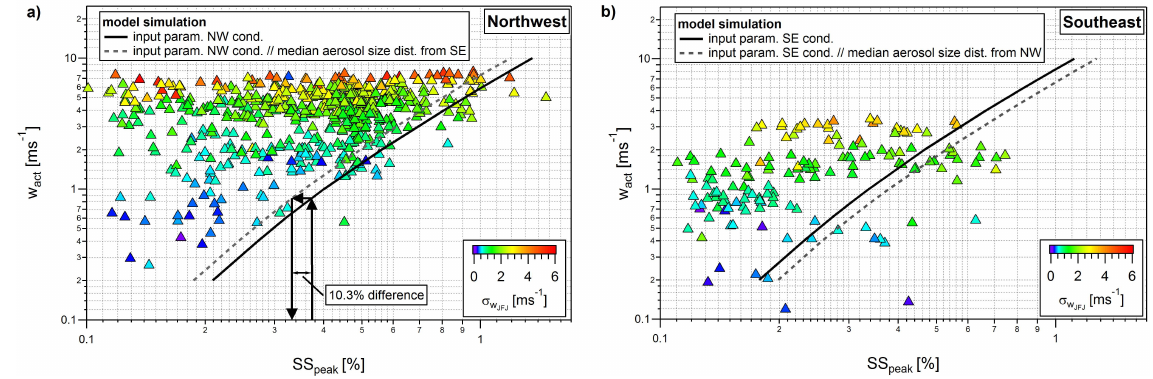
Fig. 9. 6min averages of the retrieved updraft velocity at point of aerosol activation ( w act ) (see text for further explanation) as a function of the effective peak supersaturation (SS peak ). The points are colour coded to show the standard deviation of the updraft velocity measured at the JFJ ( σ wJFJ ). Panel (a) shows results for the northwest wind case, panel (b) shows results for the southeast wind case. The black line indicates the model simulations with mean input parameters for each wind direction for CLACE2011. The grey dotted line indicates the model simulations with median input parameters for each wind direction for CLACE2011 but with swapped aerosol size distribution as input